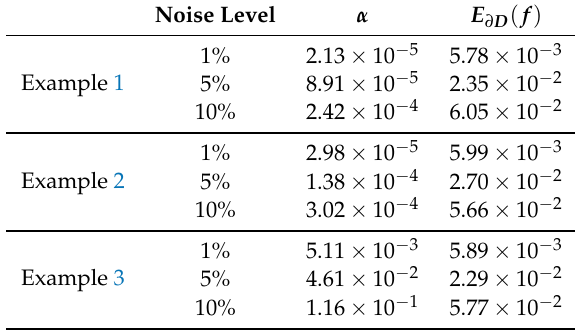
Table 1. The values of the regularization parameter, α , and the corresponding errors, E ∂ D ( f ) , obtained using the presented method, and various amounts of noise added in the boundary data, for Examples